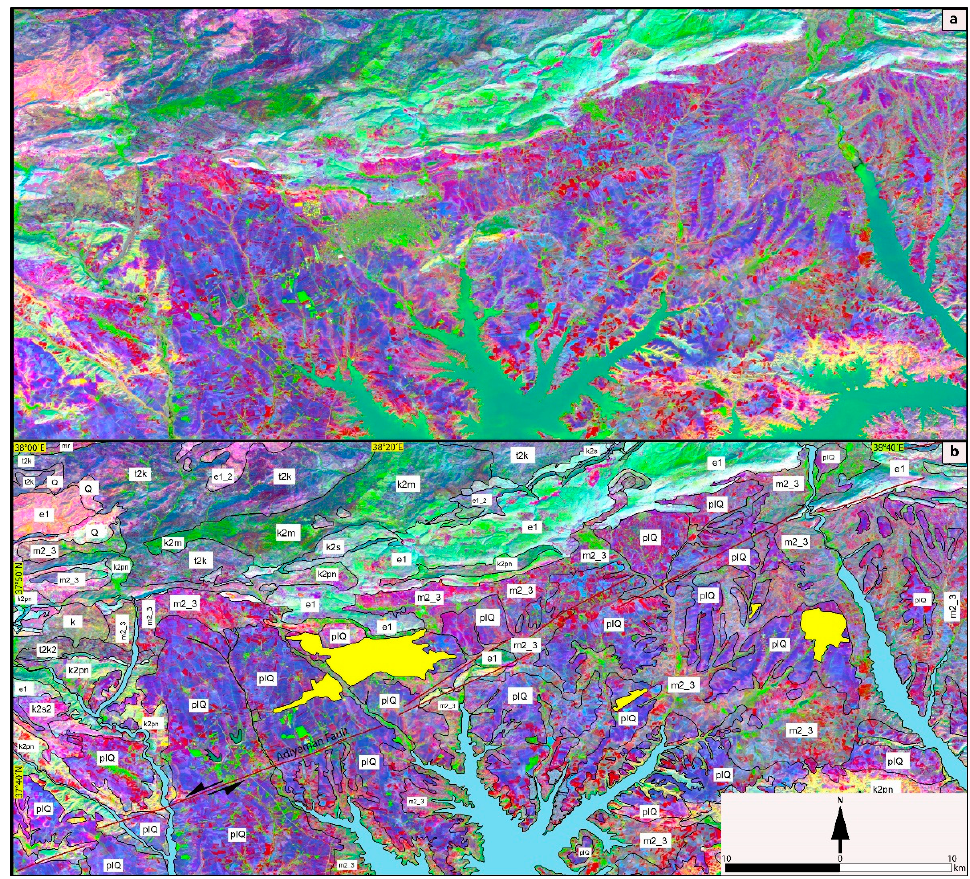
Figure 3. ( a ) Landsat 8 principal component analysis RGB-134 image. ( b ) PCA image with lithological polygons. Areas of settlements are defined by yellow polygons.